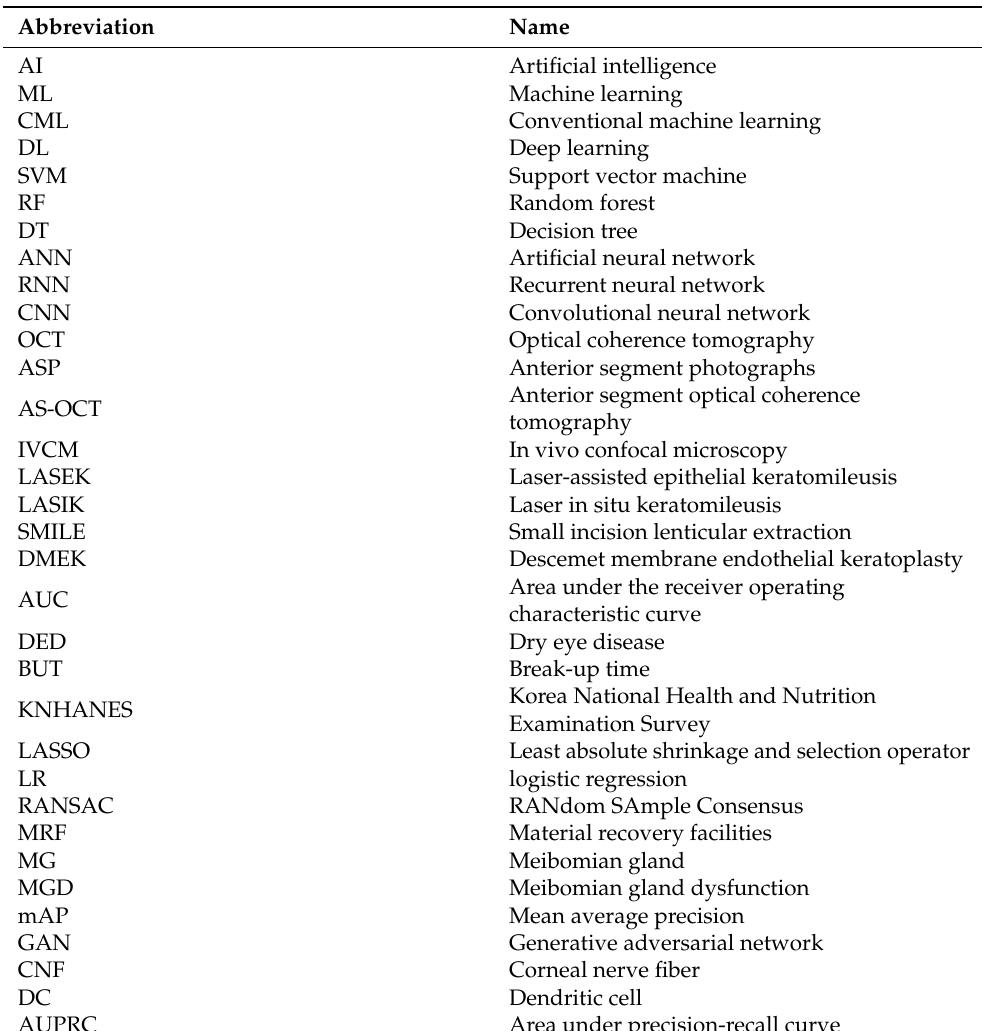
Table 1. List of abbreviations used in the review